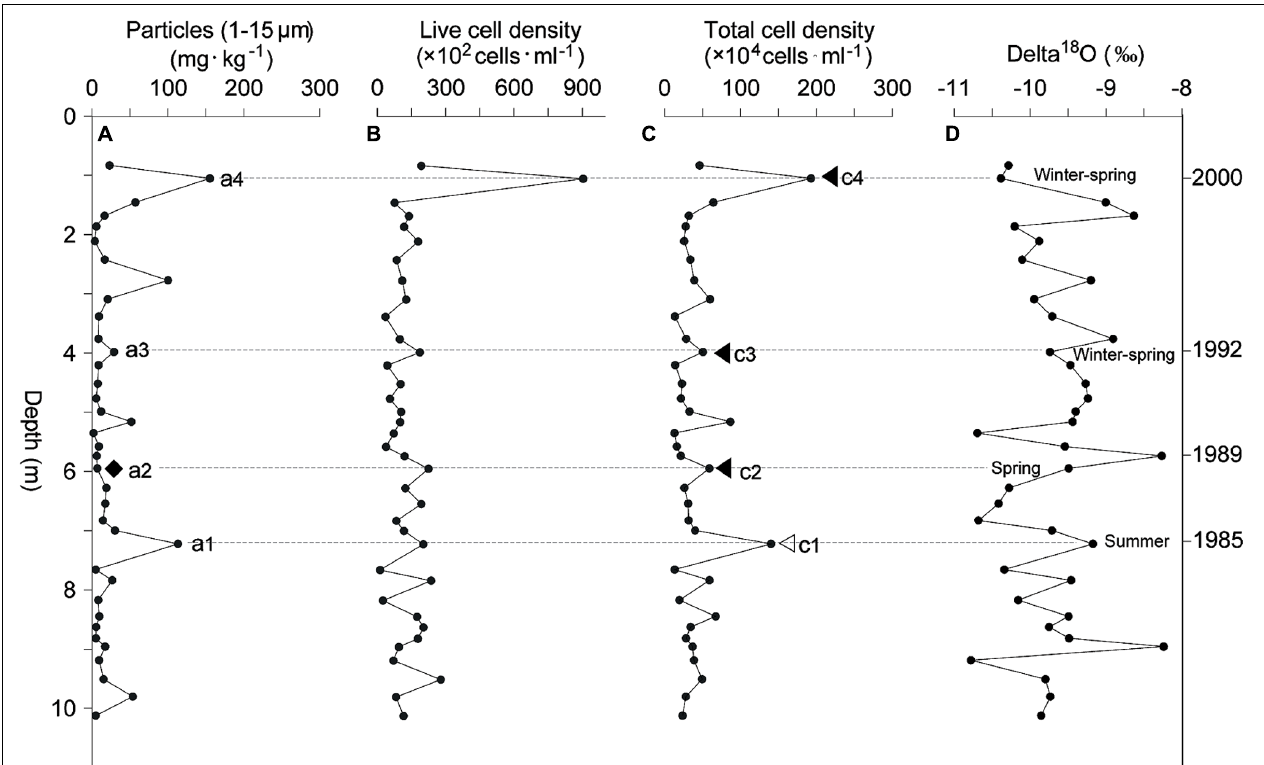
FIGURE 4 | Bacterial cell density, mineral particles, and δ 18 O in the Dunde ice core. (A) Mineral particle concentration along the depth profile. Total microparticle concentrations were measured by using a Coulter counter Multisizer3 (Beckman). (B) Live cell density. (C) Total bacterial cell density. The live and total bacterial cell density were estimated by using flow cytometer and cFDA/PI-stain. (D) δ 18 O value. The δ 18 O value was measured by Finnegan MAT-252 gas stable isotope ratio mass-spectrometer. In this study, the ice core section at 0.54–9.81 m depth was dated by using seasonal δ 18 O variations and annual visible dust layers, and confirmed by the 51-m-long Dunde ice core drilled at the same site and in the same year 2002 (Takeuchi et al., 2009). The winter-spring seasons of 1992 and 2000 were identified and confirmed by the deep valleys of δ 18 O and dust peaks, the summer of 1989 was identified by the peak of δ 18 O, and the summer of 1985 was confirmed by both of the δ 18 O and dust peaks,